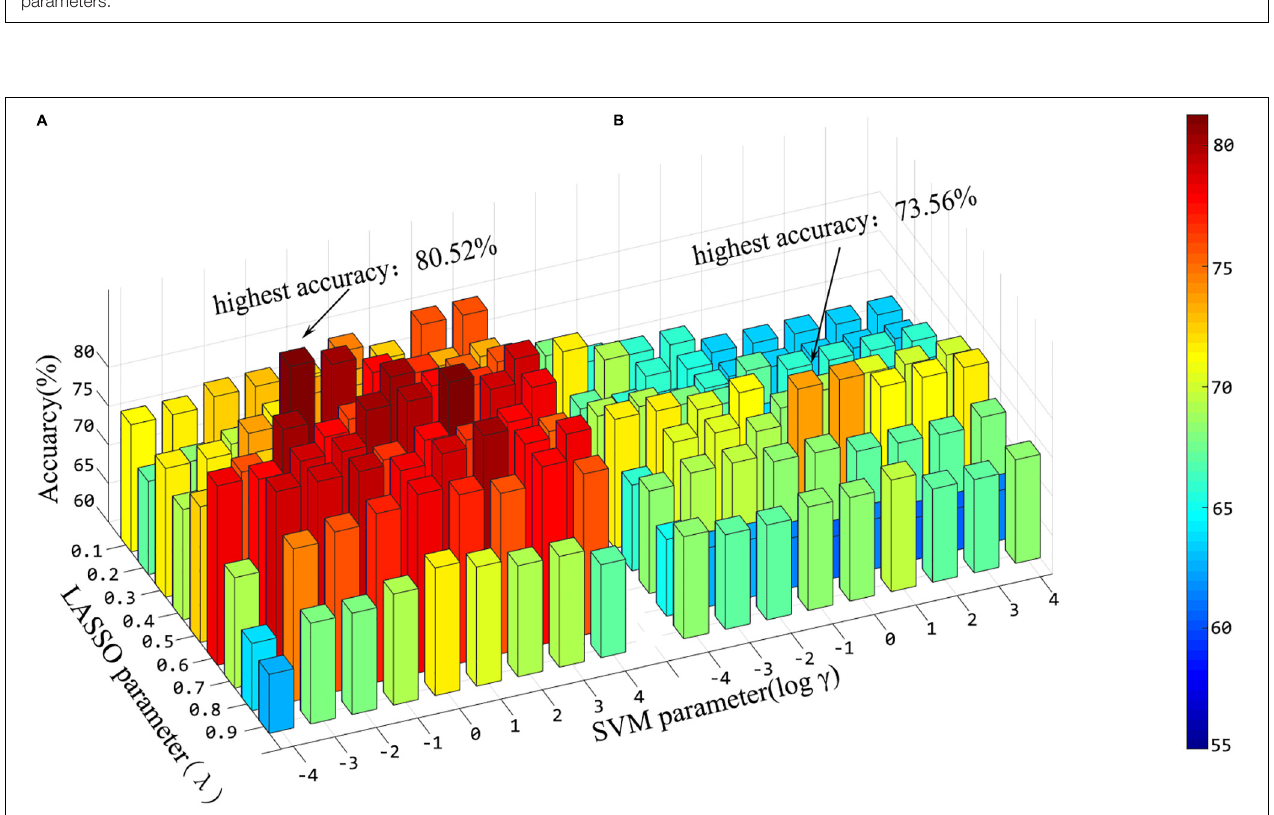
FIGURE 7 | Histogram of classification accuracy of the “hierarchical sub-network method” (A) and the “full-network FCN method” (B) under various hyper-parameter combinations.